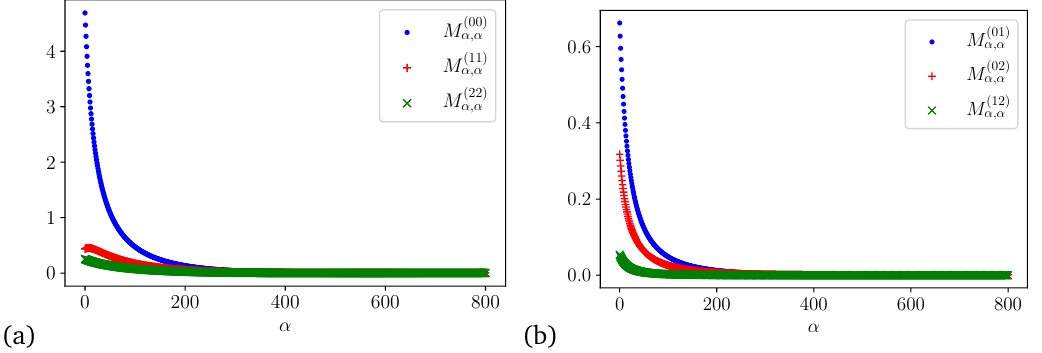
( ab ) , defined in α , β